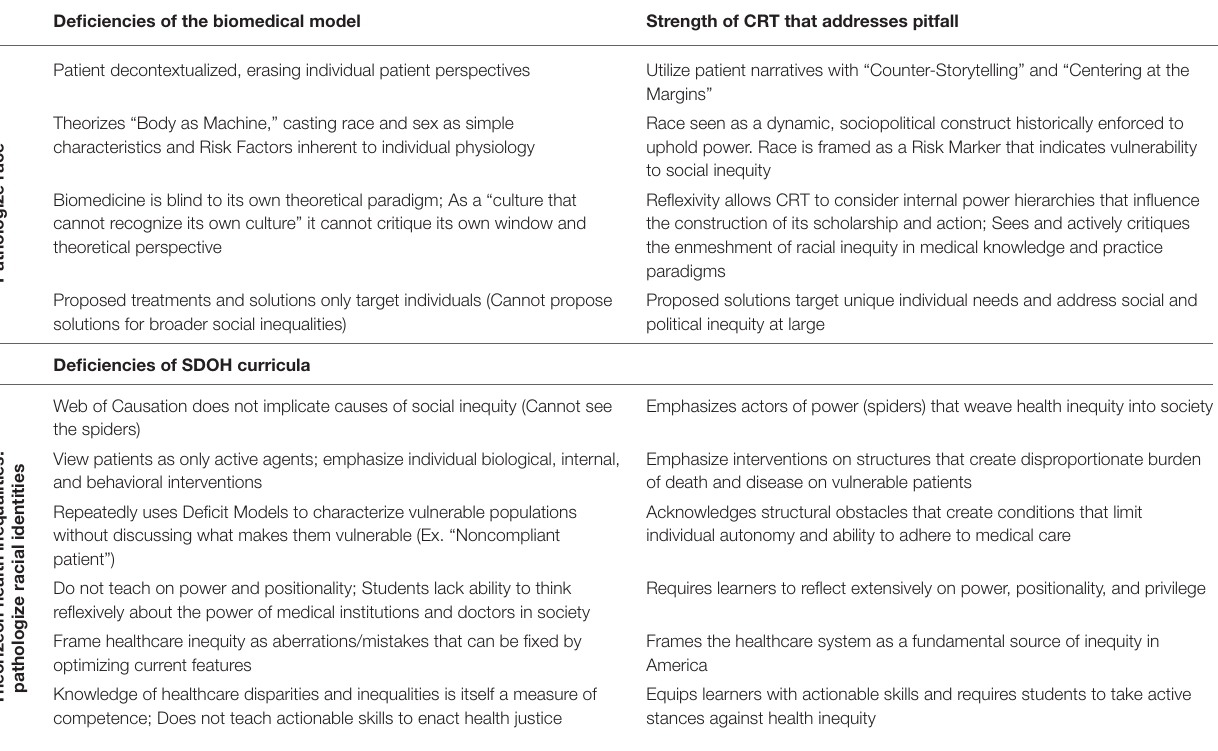
TABLE 1 | How critical race theory addresses deficiencies in existing medical curricula. Deficiencies of the biomedical